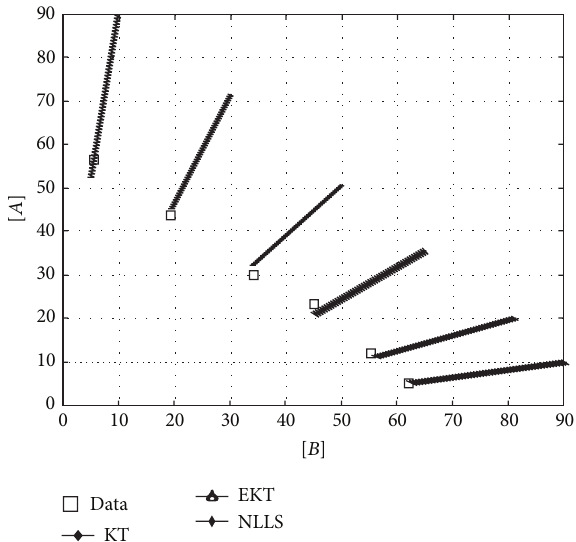
Figure 5: Evolution of the concentrations of the comonomers for all experiments. The molar concentrations are given as percentages of the initial total molar concentration.